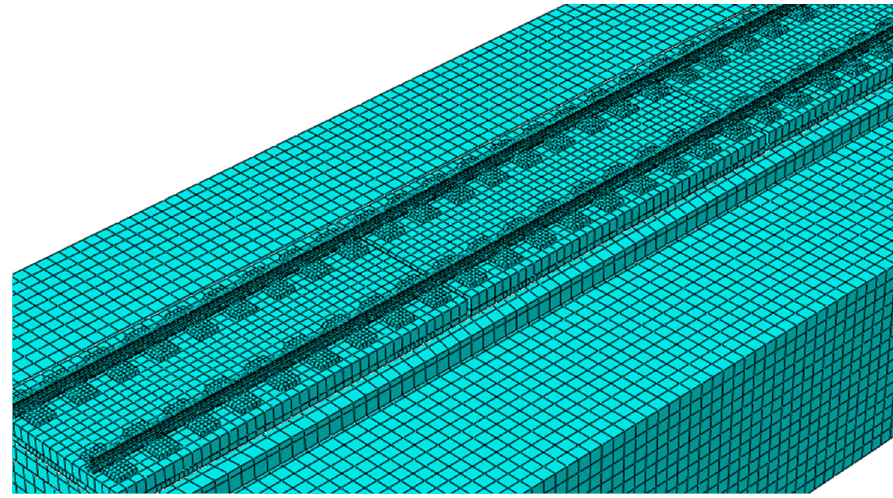
Figure 3. Finite element model of CRTSIII SBT.